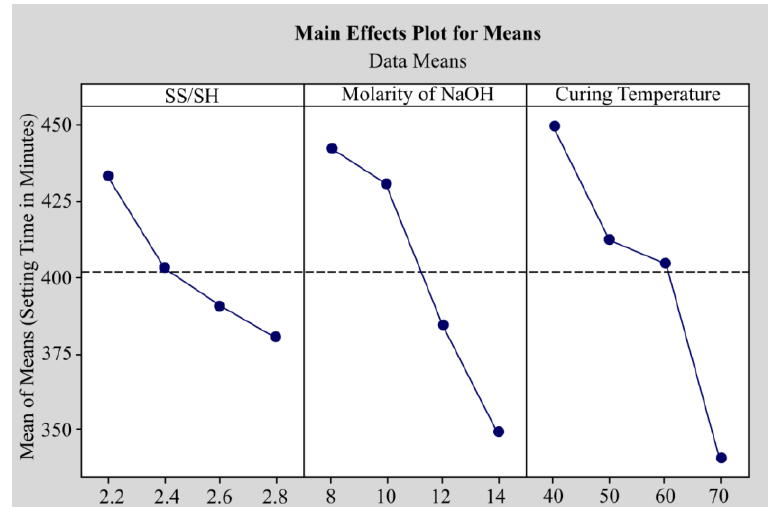
Figure 13. Main effects plot for S/N ratios based on compressive strength [146].